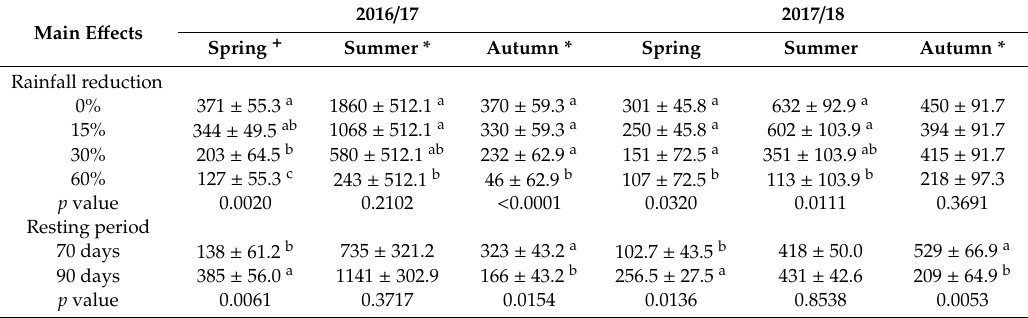
Table 6. Main e ff ect of resting period and rainfall reduction on decreaser grass (mean ± S.E) species (kg.ha − 1 ).